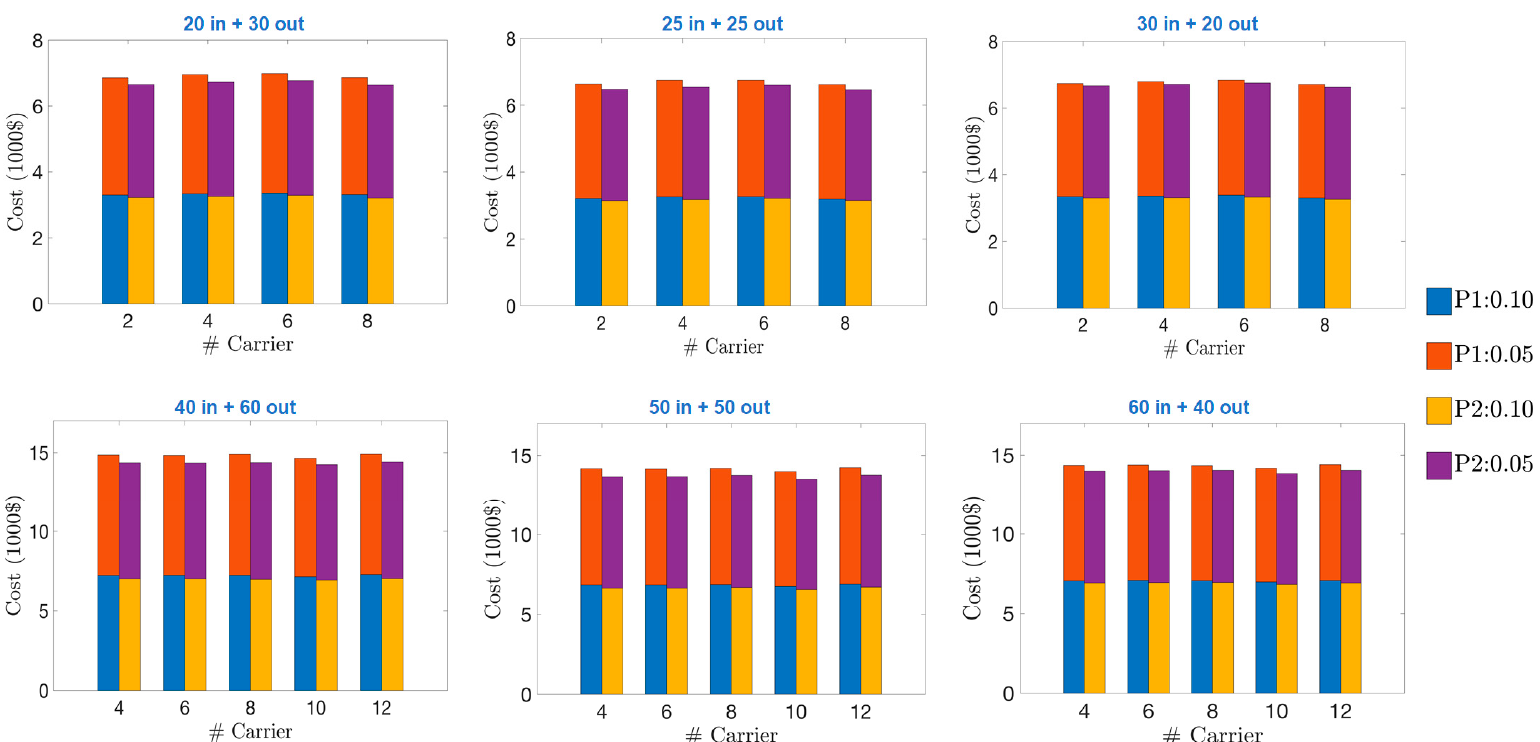
Figure 5. Carrier cost of 50 and 100 shipments under Propositions 1 and 2.